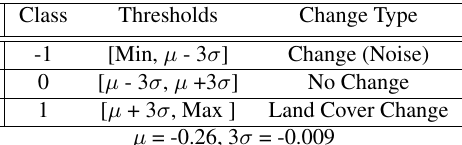
Table 1: Change thresholds set after band differencing the near- infrared band between February 2019 and April 2019 in the Crab- tree Creek watershed,